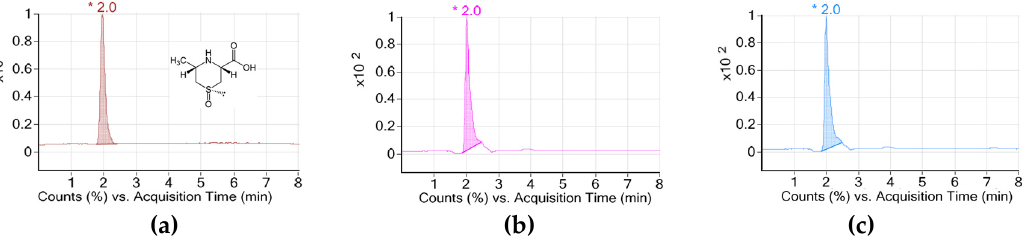
Figure 1. Chromatograms of cycloalliin in ( a ) standard, ( b ) aqueous, and ( c ) ethanol extracts of A. hookeri analyzed by LC/MS.